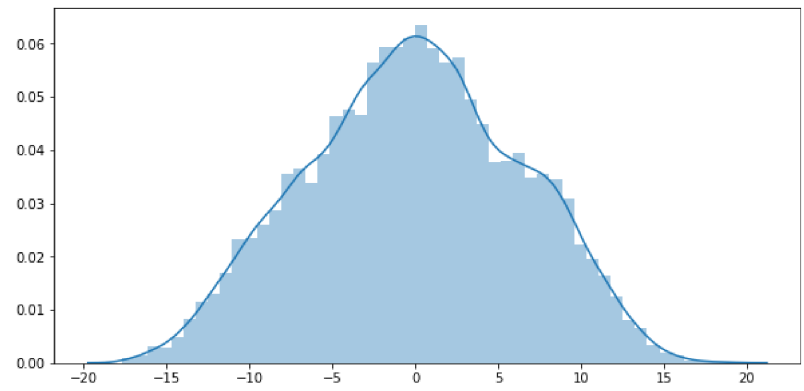
Figure 7. DNNR Residual.